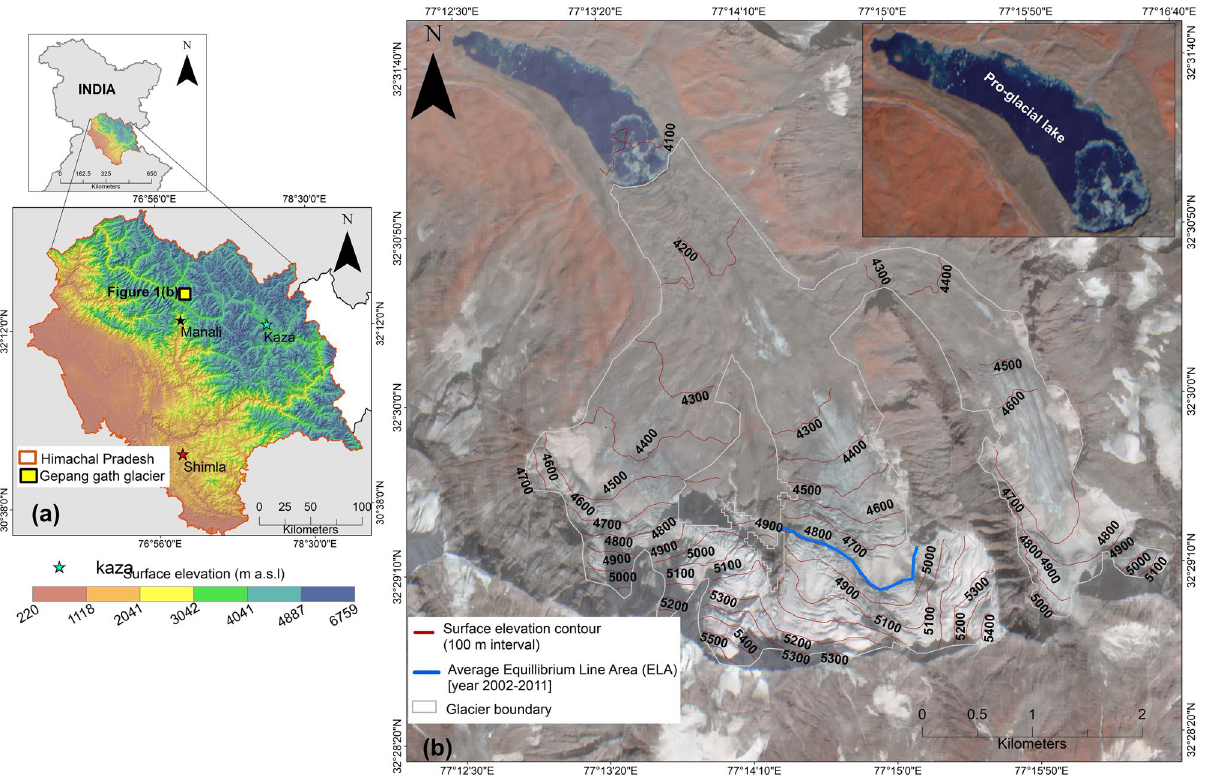
Figure 1. ( a ) The Gepan gath glacier is located in the state of Himachal Pradesh, India. State boundaries are shown in red outlines. The glacier is represented as yellow square. The meteorological stations namely Shimla, Kaza and Manali have been represented by red, green and black coloured stars. The above features have been overlayed over the DEM of that region (downloaded from https:// bhuvan- app3. nrsc. gov. in/ data/ downl oad/ index. php). ( b ) The glacier boundary is shown in white outlines and is overlayed on Planet view imagery (dated: 21st October, 2020).the elevation contours (at 100 m intervals) are shown in black coloured lines. A zoomed picture of the Gepan gath lake has been shown on the top right corner. The ELA for the period 2002–2011 has been shown as a blue coloured line. (URL: https:// deskt op. arcgis.